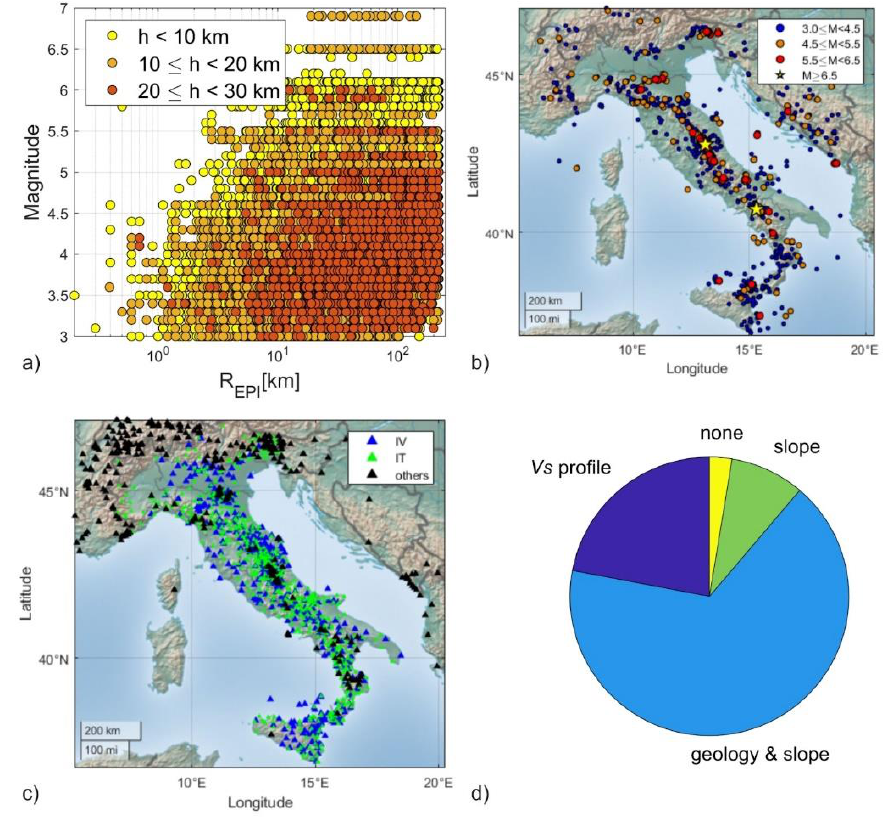
Figure 1. ( a ) Magnitude (M) — Distance (R EPI ) distribution grouped by hypocentral depth (h); ( b ) geographic distribution of earthquake epicenters with magnitude (M); ( c ) geographic distribution of seismic stations (IV: network code of the National Seismic Network (RSN, http://cnt.rm.ingv.it/en/instruments/network/IV; last accessed on 18 July 2022); IT: network code of the National Accelerometric Network (RAN, http://ran.protezionecivile.it/IT/index.php; last ac- cessed on 18 July 2022); ( d ) availability of site information.